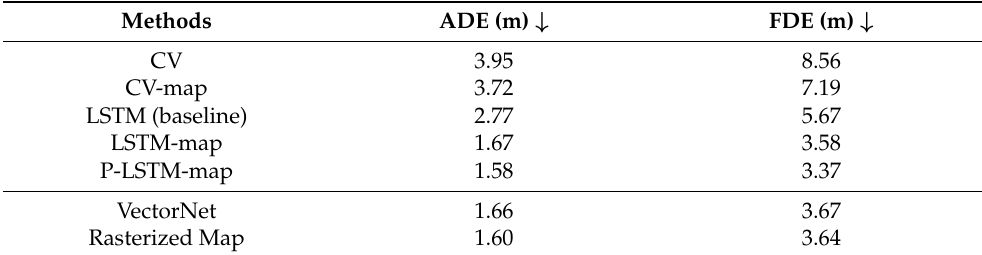
Table 3. Ablation study of prediction approaches integrating lane orientation information on the Argoverse dataset. Test results of rasterized map and VectorNet are according to their original